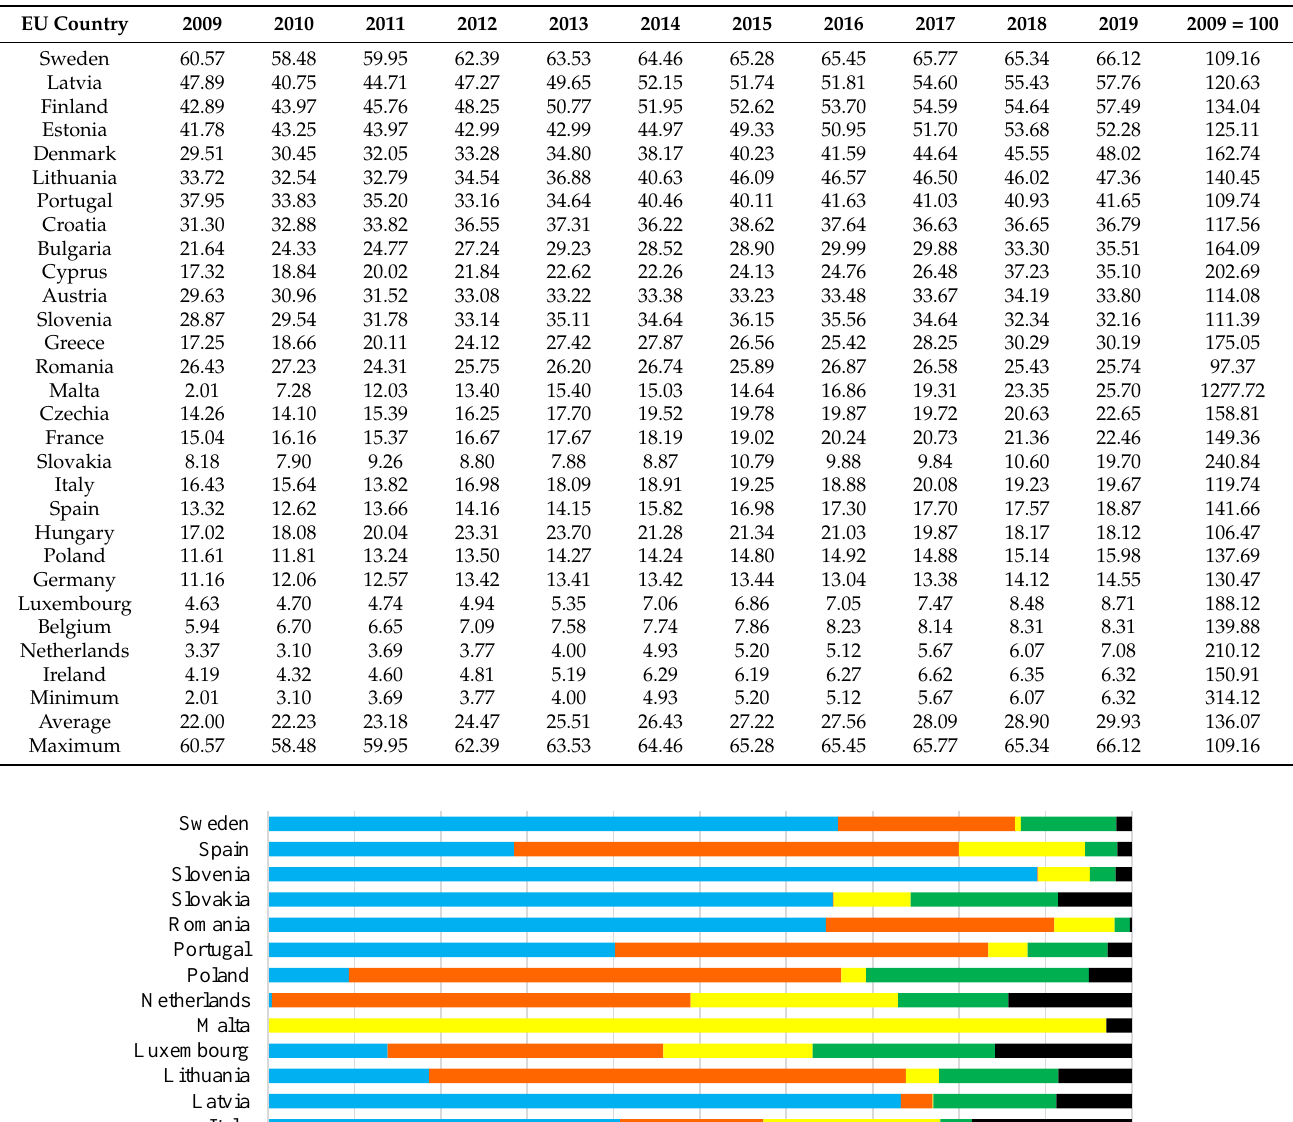
Table 3. Share of renewable energy in heating and cooling in years 2009–2019 (Note: countries were ordered by 2019 index value, from highest to lowest).